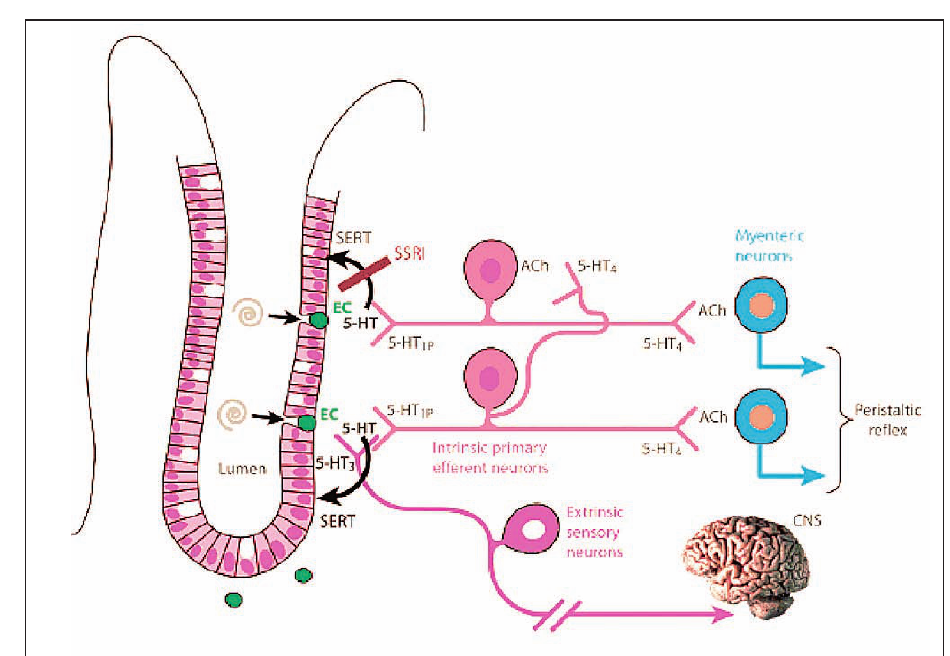
Figure 3 Action of serotonin in the bowel wall. Sero- tonin released from stimulated entero- chromaffin cells activates submucosal intrinsic primary effe- rent neurons (pink) through 5-HT1P re- ceptors. The latter spread information to the myenteric plexus (blue) allowing peri- staltic reflexes. Sero- tonin also activates extrinsic sensory neurons (purple) which relay informa- tion to the central nervous system. Black arrows repre- sent reuptake of